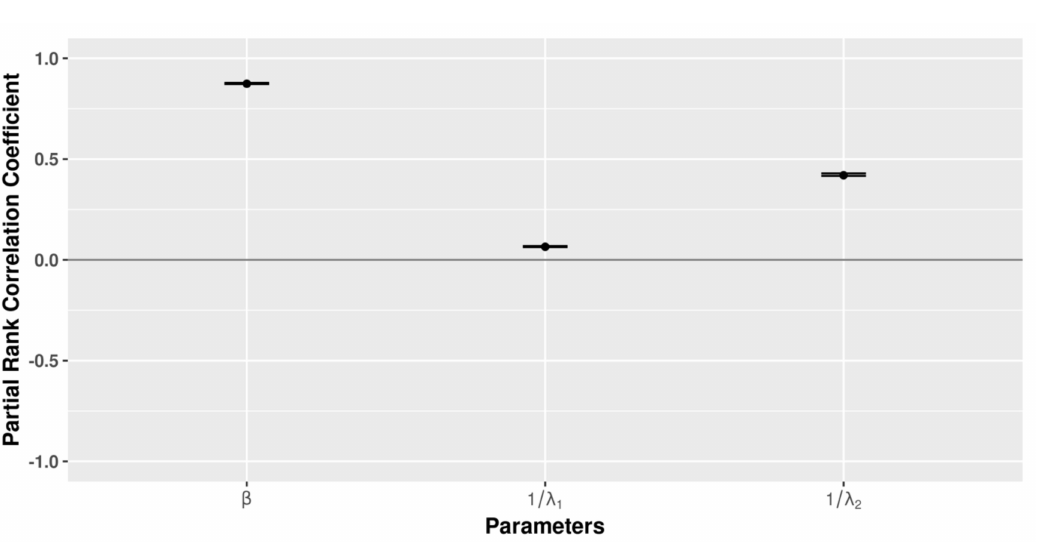
, and 1/ λ 2 with a λ 1